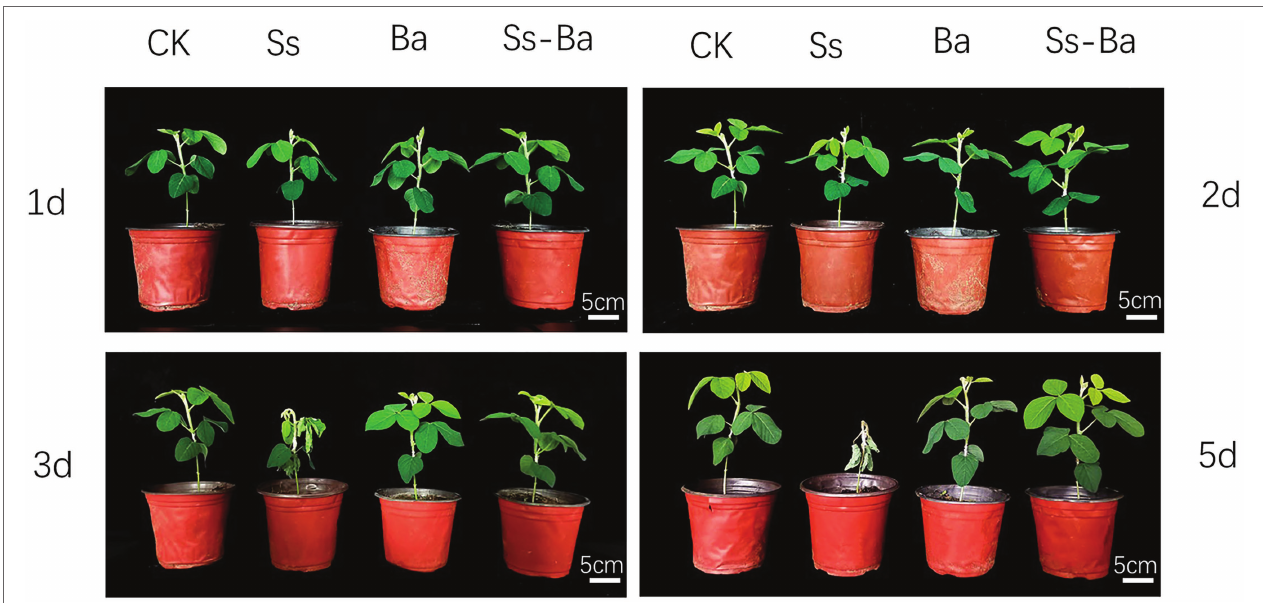
FIGURE 2 | Soybean seedling inoculation experiment of Bacillus amyloliquefaciens antagonizing the growth of S. sclerotiorum . Ba, Ss, and Ba+Ss indicated that soybean seedling was inoculated with B. amyloliquefaciens , S. sclerotiorum and their mixture, respectively. Ck, soybean seedling wounded using a scalpel and not inoculated was used as the